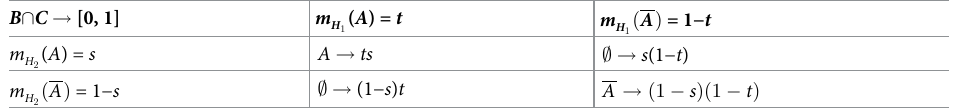
Table 1. Dempster combination enabling the expression of a joint model. A , B , C � Θ